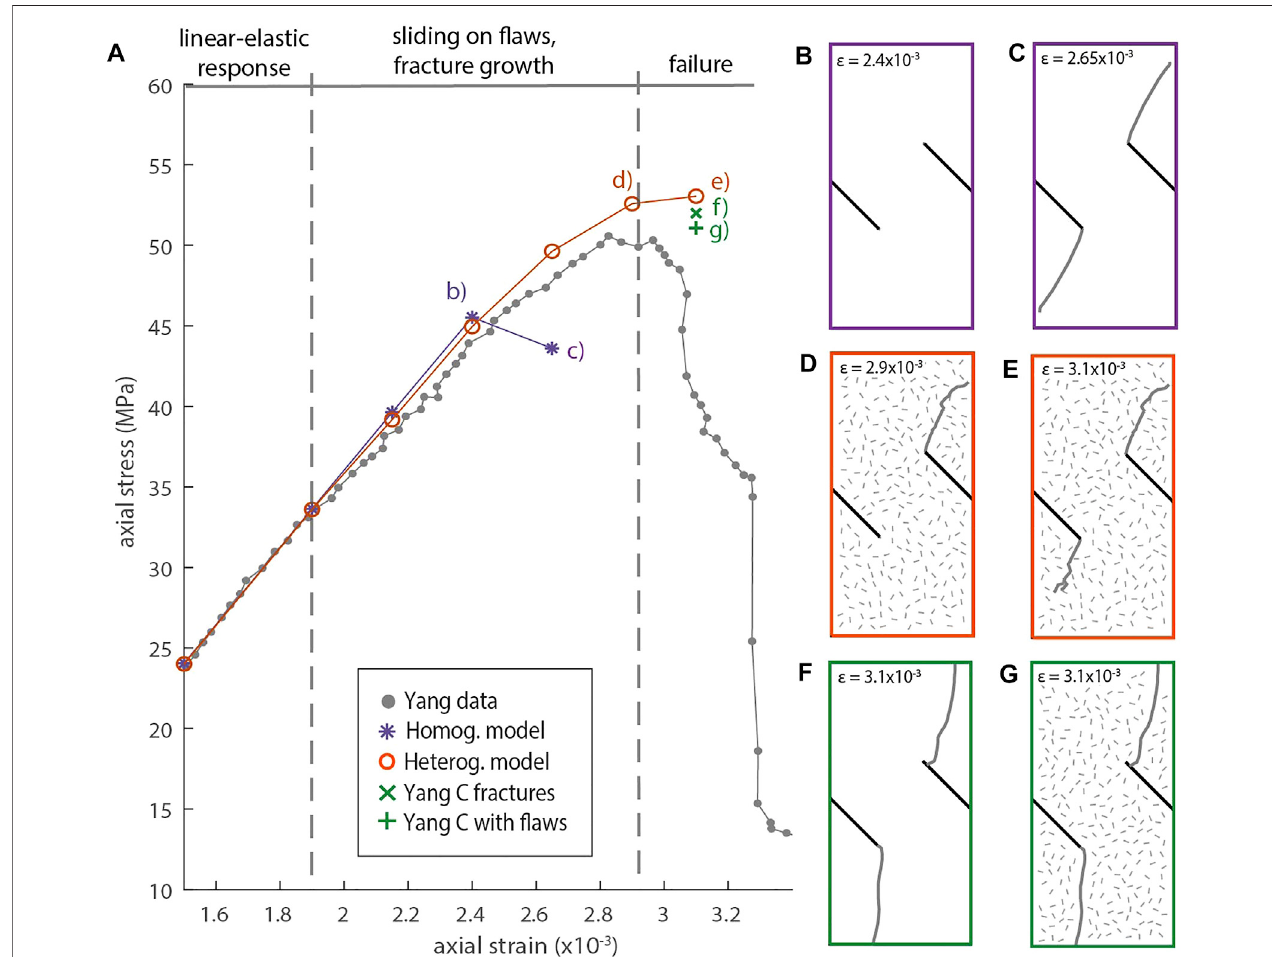
FIGURE 9 | (A) Stress-strain data from Yang et al. (2009) experiment C is shown in grey circles. Stress-strain values from numerical simulations using two homogeneous models and a model incorporating distributed microcracks are shown in purple diamonds and asterisks, and orange circles, respectively. Green ‘ + ’ and ‘ x ’ symbols show post-failure stress values from models using the experimentally-observed fracture patterns, with and without inclusion of distributed microcracks respectively. (B) The fi rstfracturegrowthfrombothpre-cutcracksoccursinthehomogeneousmodelatstrain2.4e-3,correspondingtothelabeledlocationonthe stress-strainplot. (C) Completefracturegrowthinhomogeneousmodelatstrain2.65e-3. (D) Fracturegrowthintheheterogeneousmodelstartsfromtheupperpre-cut crack fi rstatstrain2.4e-3,growingtotheedgeofthemodeloncestrainreaches2.9e-3. (E) Fullfracturegrowthfrombothpre-cutcracksintheheterogeneousmodelat strain 3.1 e-3. (F) Model incorporating the observed fracture geometry of the experiment without microcracks corresponds to green cross on stress-strain plot, and (G) model incorporating observed fracture geometry and distributed microcracks, corresponds to green plus on stress-strain plot.